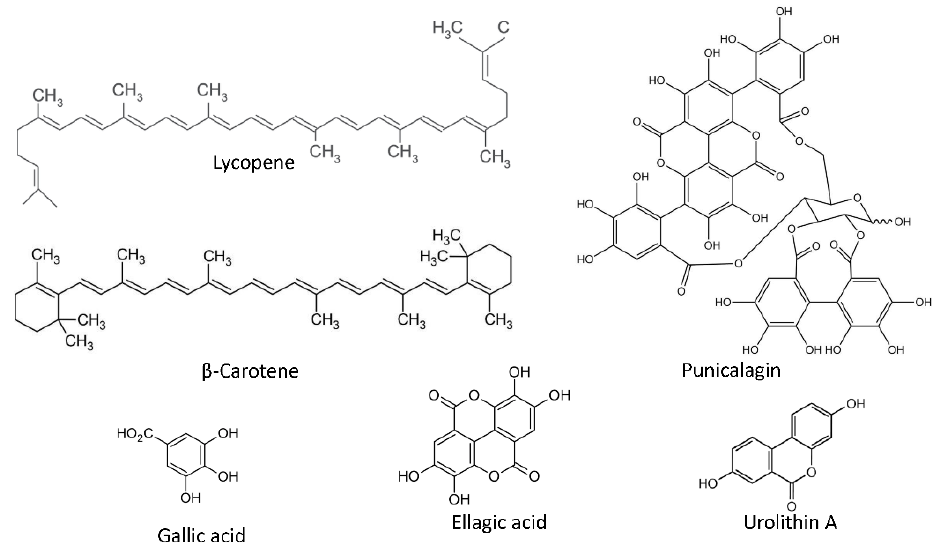
Figure 7. Chemical structures of some antiangiogenic phytochemicals found in fruits. They include carotenoids (lycopene and β -carotene), rich in tomato, punicalagin, the major fruit ellagitannin, abundant in pomegranate and other compounds derived from the hydrolysis of gallitannins and ellagitannins (gallic acid, ellagic acid and urolithin A).